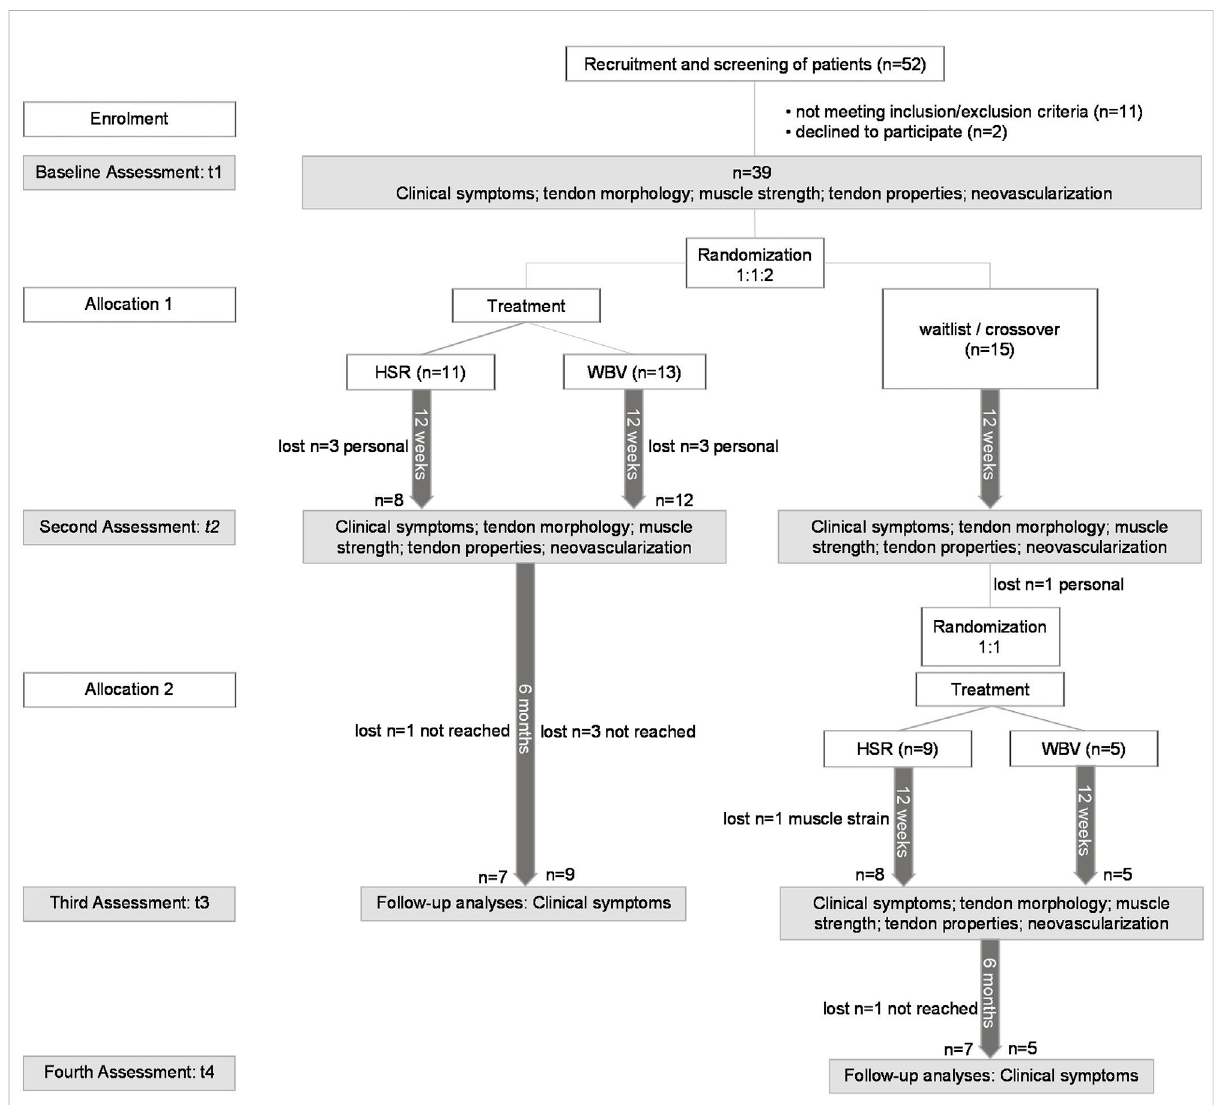
FIGURE 2 Study fl ow. HSR = heavy slow resistance training; WBV = whole body vibration training. Personal = drop out due to personal reasons: moved away/no time for the study; not reached = patient could not be reached by phone or email after post-test; muscle strain = patient suffered a rectus femoris muscle strain during exercise and was not able to